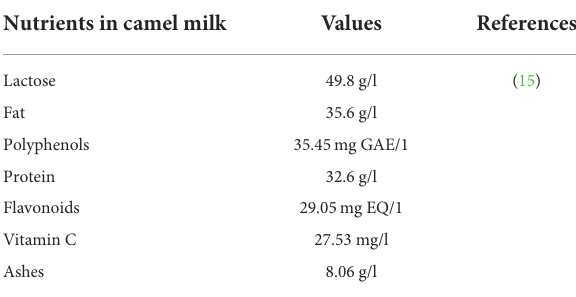
TABLE 1 The nutritional components of camel